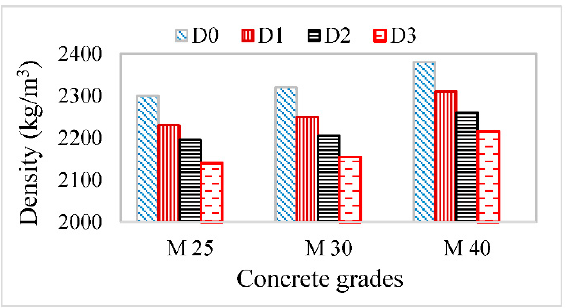
Figure 4. The density of concrete grades. D0 (100% PLC), D1 (95% PLC + 5% CNA), D2 (90% PLC + 10% CNA), D3 (85% PLC + 15% CNA).